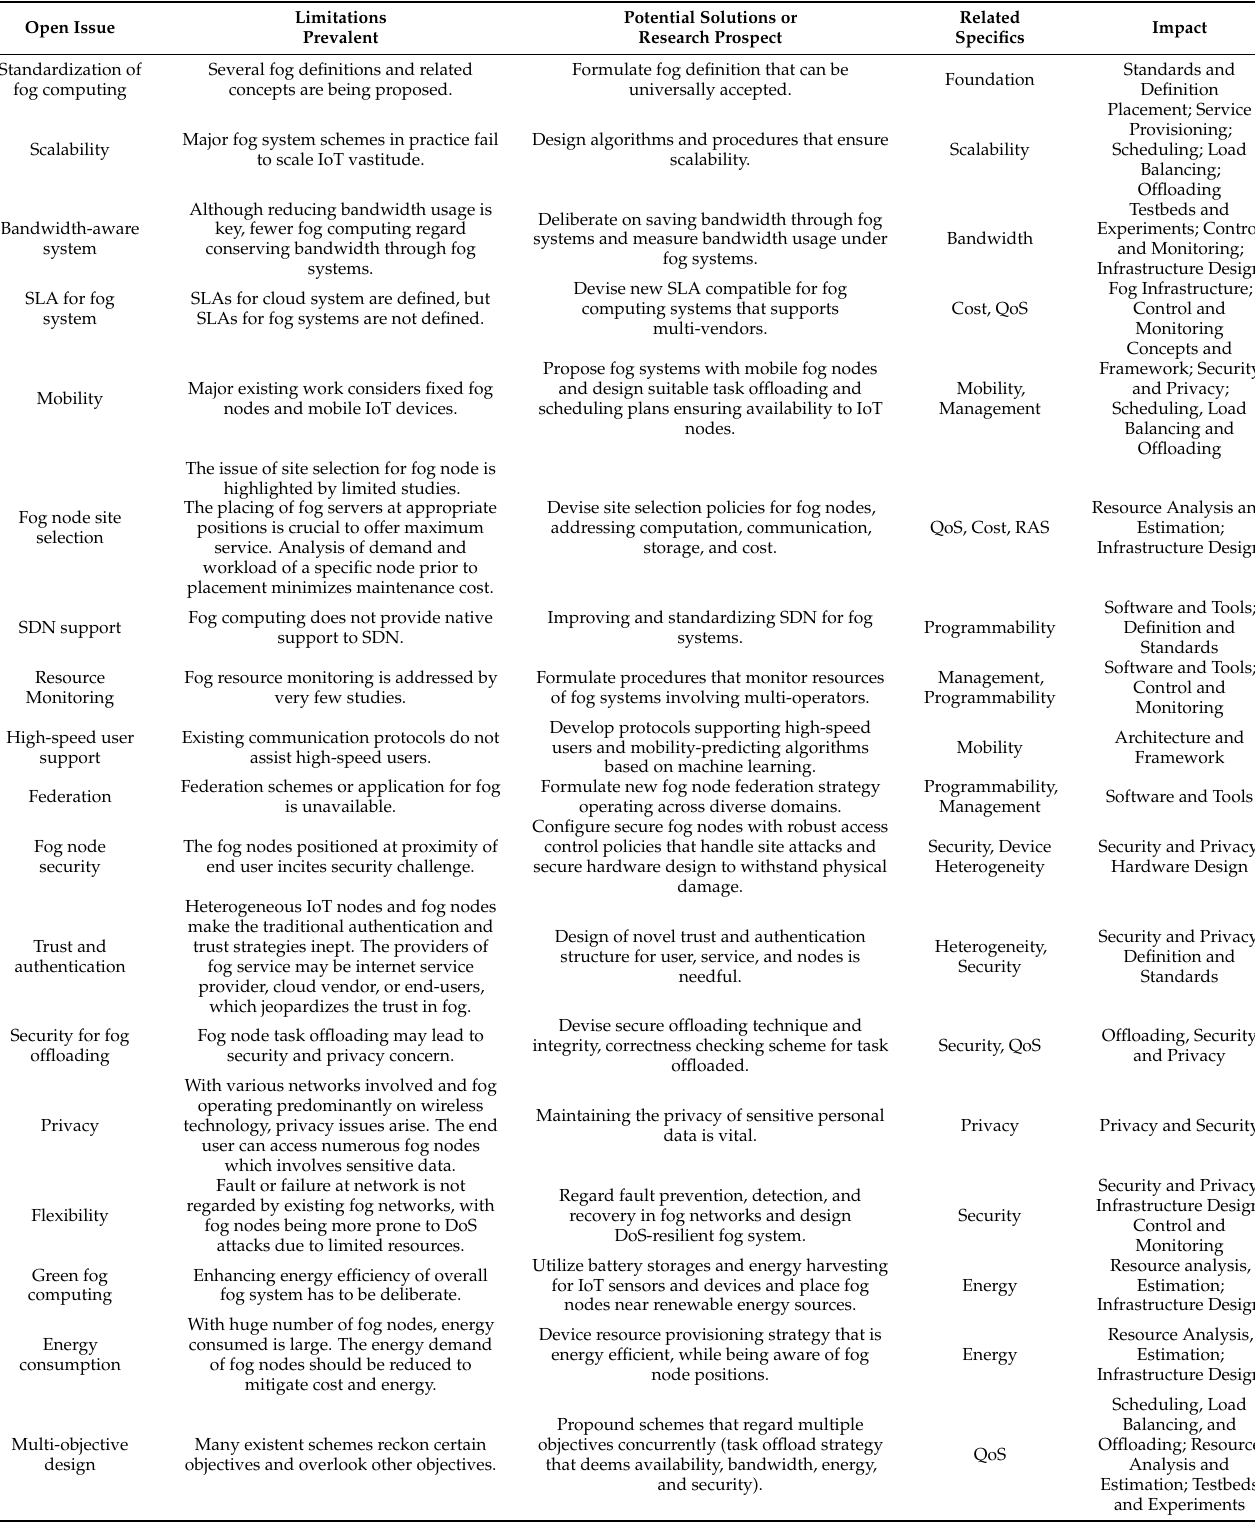
Table 5 furnishes the summary of open issues and potential solutions concerned with fog computing. Table 5. Open challenges and future research